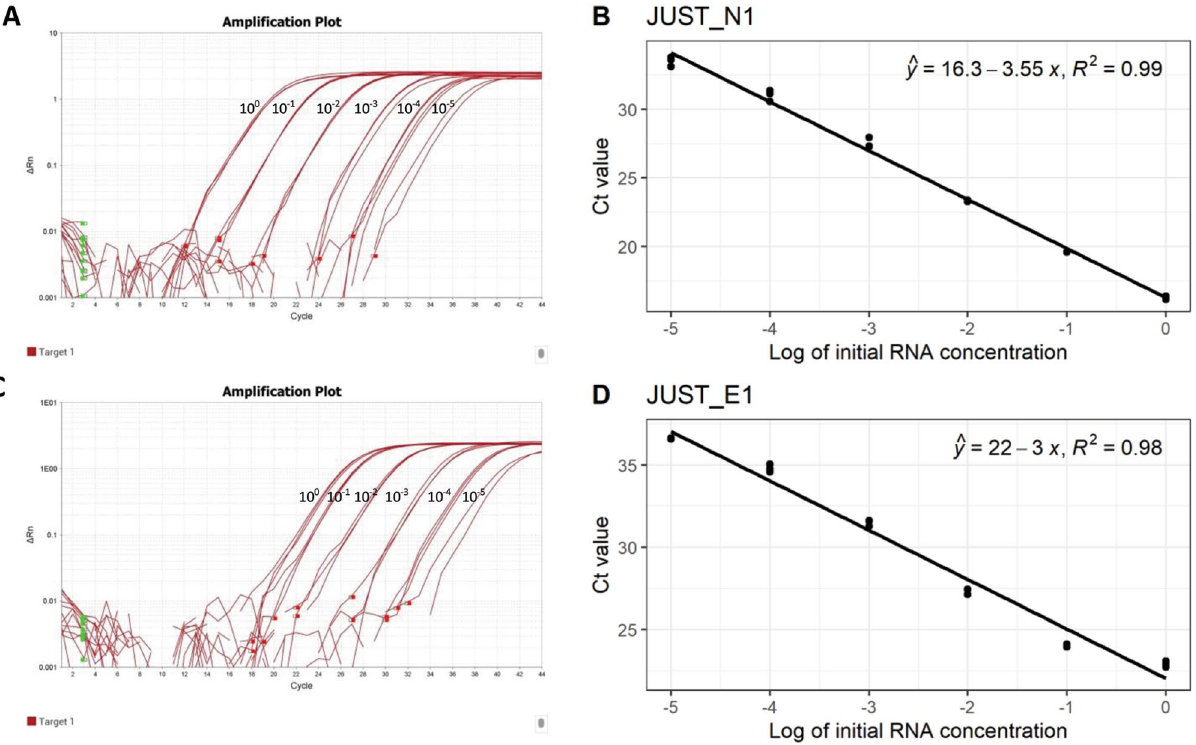
Figure 5. Standard Curve of JUST N1 and JUST E1 genes. ( a ) Amplification plot of JUST N1 gene (Linear View) in different dilutions (10 0 –10 –5 ); ( b ) standard curve of JUST N1 gene ( c ) Amplification plot of JUST E1 gene (Linear view) in different dilutions (10 0 –10 –5 ) ( d ) Standard curve of JUST E1 gene The coefficient of determination (R y ) and linear regression curve (y) were